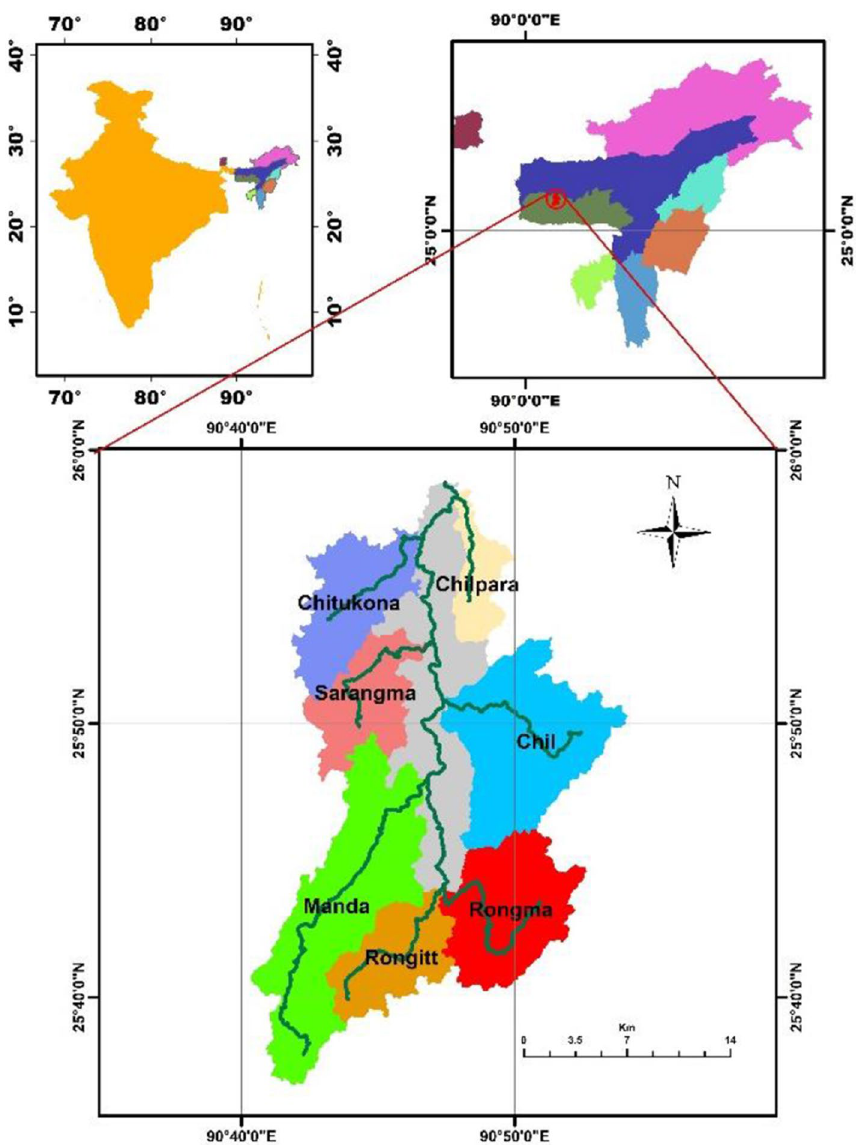
Fig. 1 Study area: